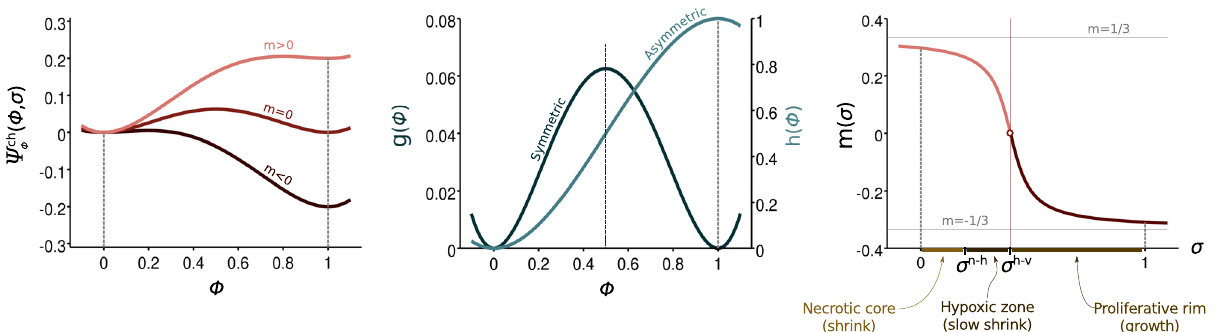
Fig 2. Chemical free energy of the tumor. The tumor chemical free energy, C ch (cid:1) , is de fi ned as a double-well potential formed by the sum of a symmetric contribution ( g ) and a non-symmetric function ( h ). The latter is multiplied by a tilting function m , that depends on the nutrient concentration. On the right hand side of the plot, σ n − h and σ h − v represent values of the nutrient concentration that de fi ne, respectively, the necrotic-hypoxic and hypoxic-viable